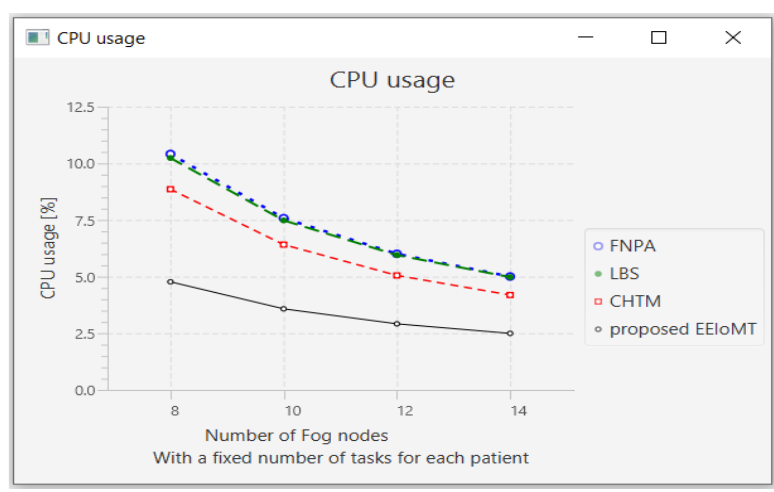
Figure 15. CPU usage comparison when changing the number of fog nodes.